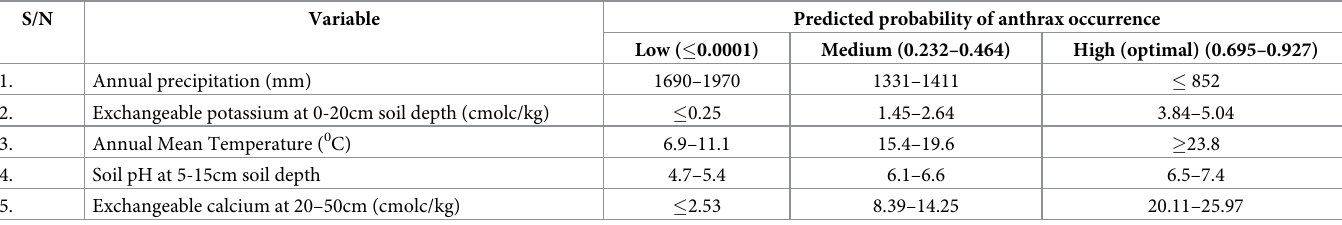
Table 5. Optimal levels of environmental variables that most predicted suitable ecological niche for distribution and survival of anthrax spores at